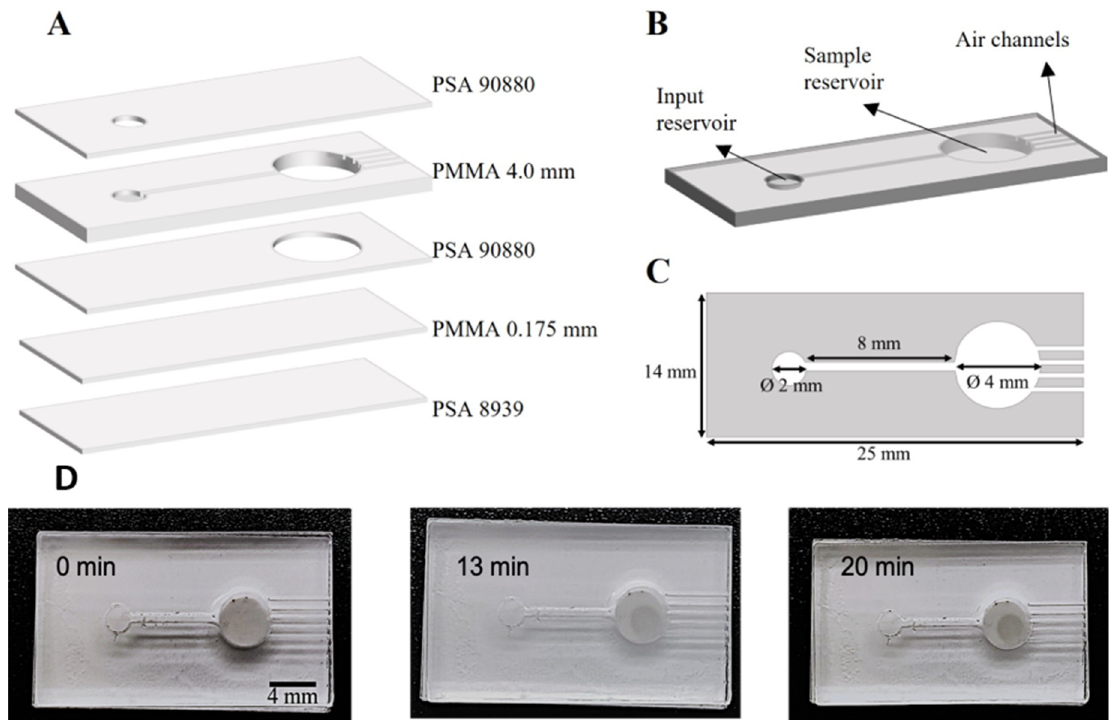
Figure 5. Microfluidic platform for the applicability of the biosystem with real sweat. ( A ) PMMA and PSA layers used for the fabrication of the microfluidic platform. ( B ) Schematic diagram of the microfluidic platform, which was 25 × 14 × 4.5 mm. ( C ) Dimensions of the microfluidic PMMA layer. ( D ) Pictures of the microfluidic platform with integrated biosystem to measure glucose in real sweat at 0 (left), 13 (center) and 20 min (right) (contrast was slightly increased in the pictures for a better appreciation of the beads). The intensity of the color increases over time due to a higher amount of glucose entering the bead.